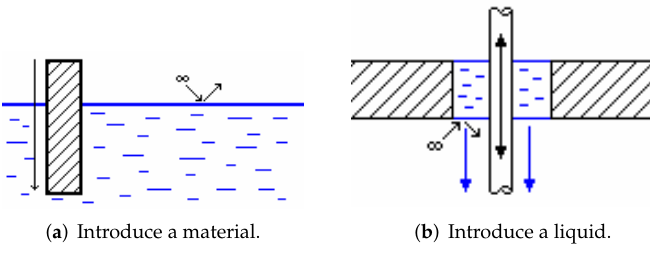
Figure 11. Inventive resolution: Introduce a material → Introduce a liquid. Considering this, the principle of pressure measuring is used, and the inventive concept solution is proposed for this case, as shown in Figure 12. If one side is at